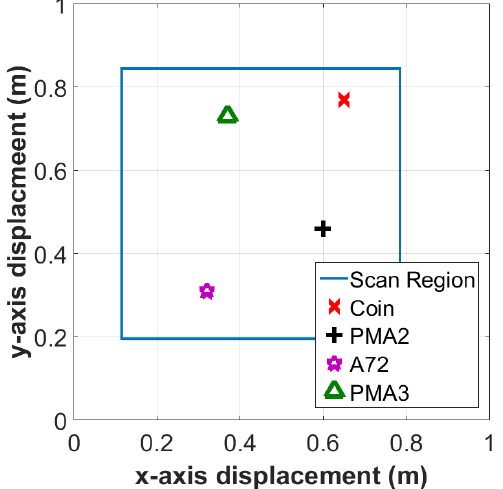
Figure 12. Locations for the objects buried in the